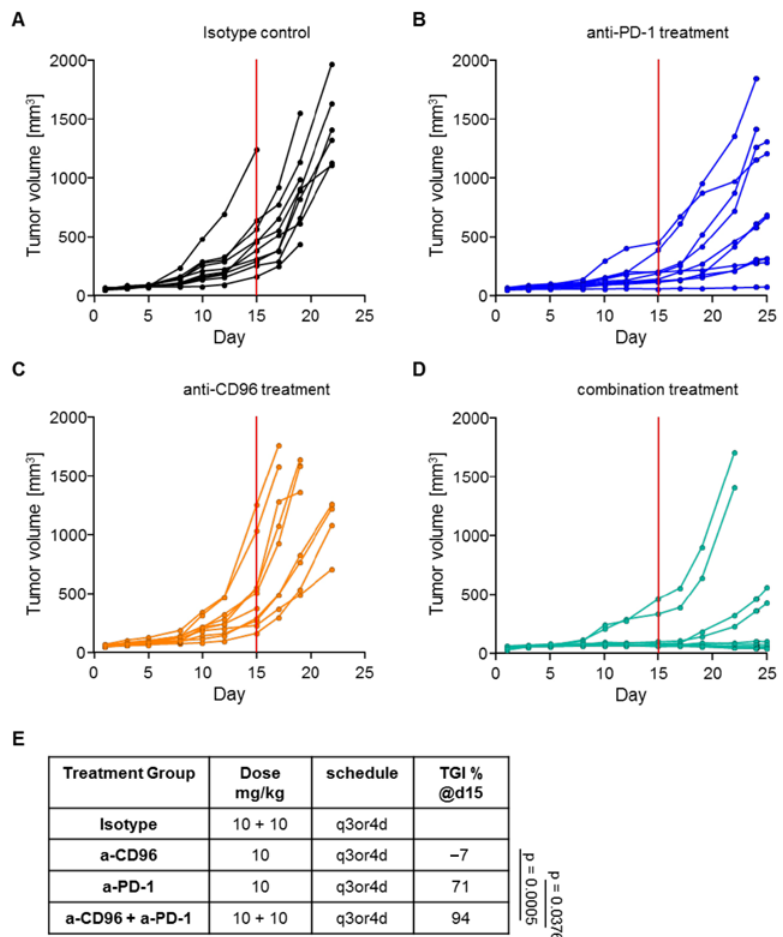
Figure 3. Tumor growth in mice treated with mAbs. Tumor volumes are shown for mice treated with ( A ) isotype control antibodies; ( B ) anti-PD-1; ( C ) anti-CD96; and ( D ) the combination of anti-PD-1 and anti-CD96. ( E ) Tumor growth inhibition (TGI) measured on day 15 (red line in graphs A-D) of the experiment for all treatment groups.